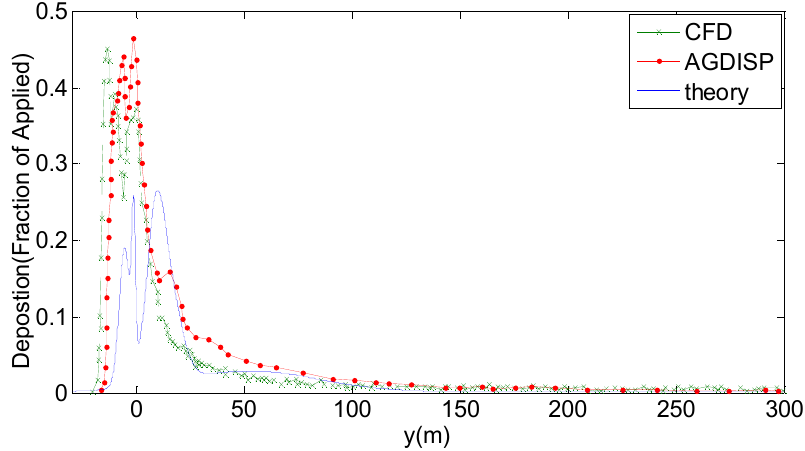
Figure 20. Comparison of deposition and drift in presence of crosswind predicted by CFD [19], AGDISP and theoretic method of this paper.